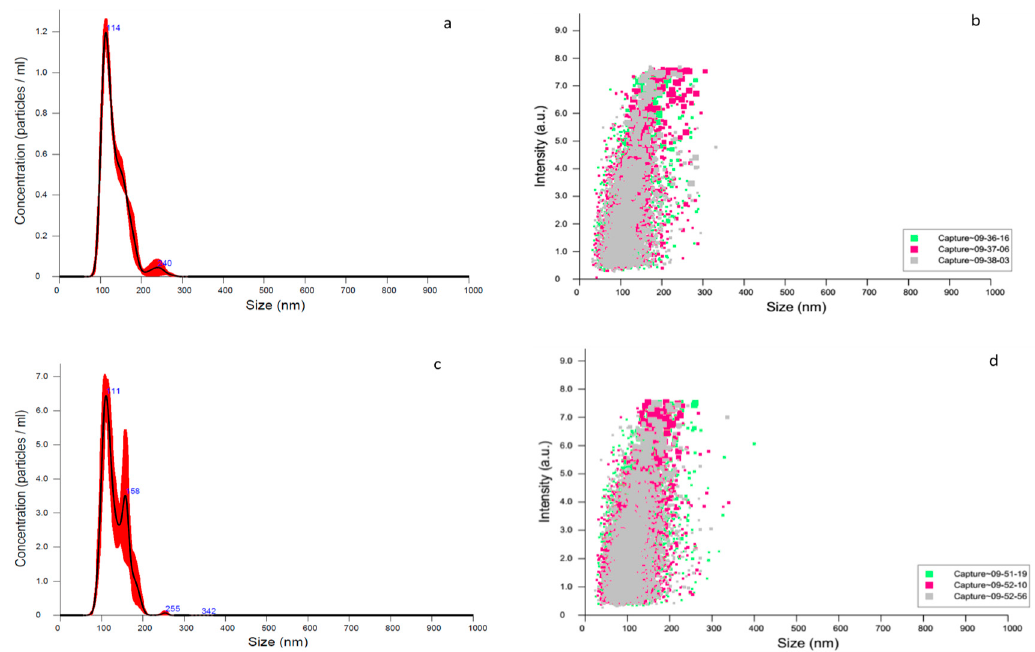
Figure 5. Particle size distribution. ( a ) The concentration of empty nanoparticles. ( b ) The distribution of empty nanoparticles. ( c ) The concentration of 4-NC nanoparticle. ( d ) The distribution of 4-NC. The photomicrography of nanoparticles obtained for SEM showed a diameter between 35.2 and 162.4 nm (Figure